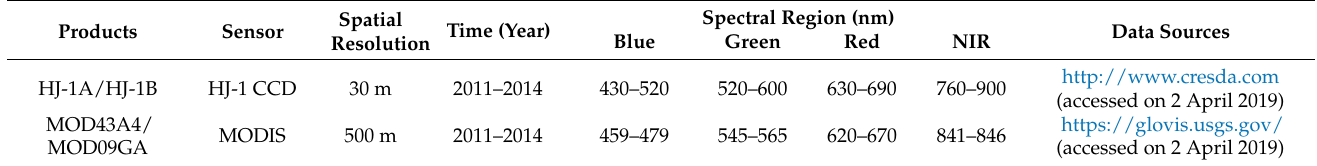
Table 1. Experimental data and band